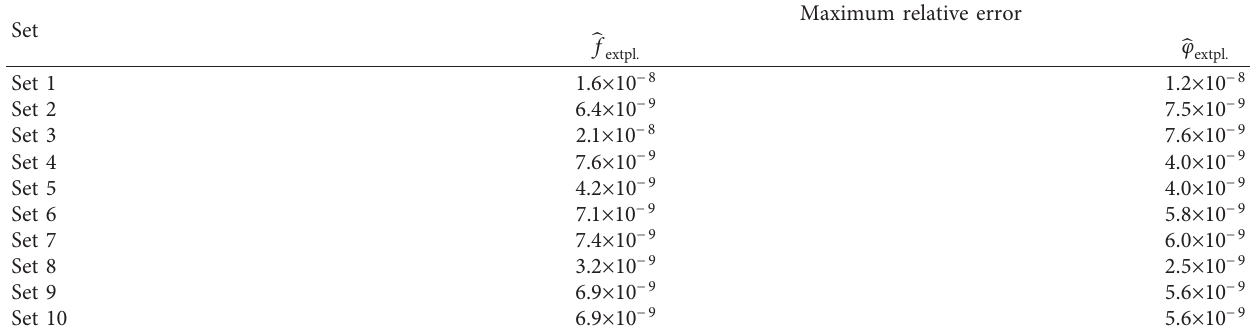
and 􏽢 φ with Δ τ � 0 . 005 and Δ v � 0 . 005. extpl . extpl .